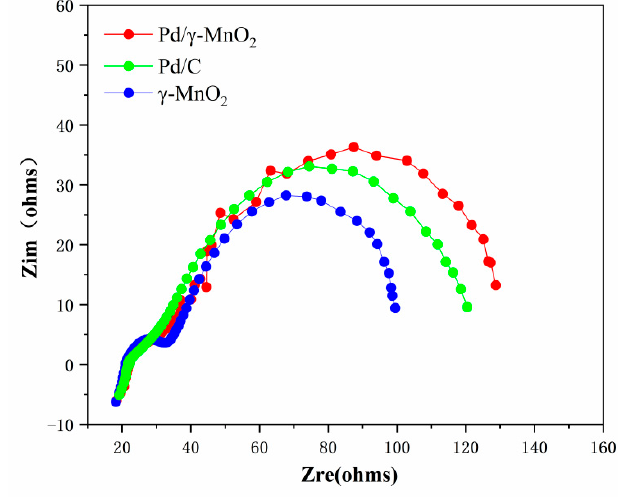
Figure 6. The NH 3 yield curves on Pd/γ -MnO 2 , Pd/C, and γ -MnO 2 catalysts at various potentials.